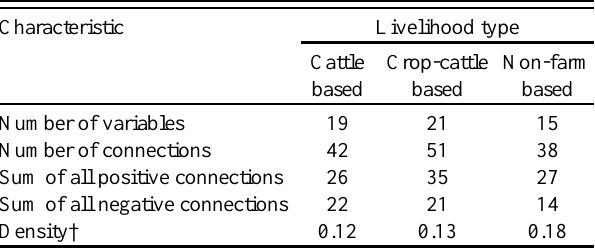
Table 2. Key characteristics of fuzzy cognitive map diagrams and